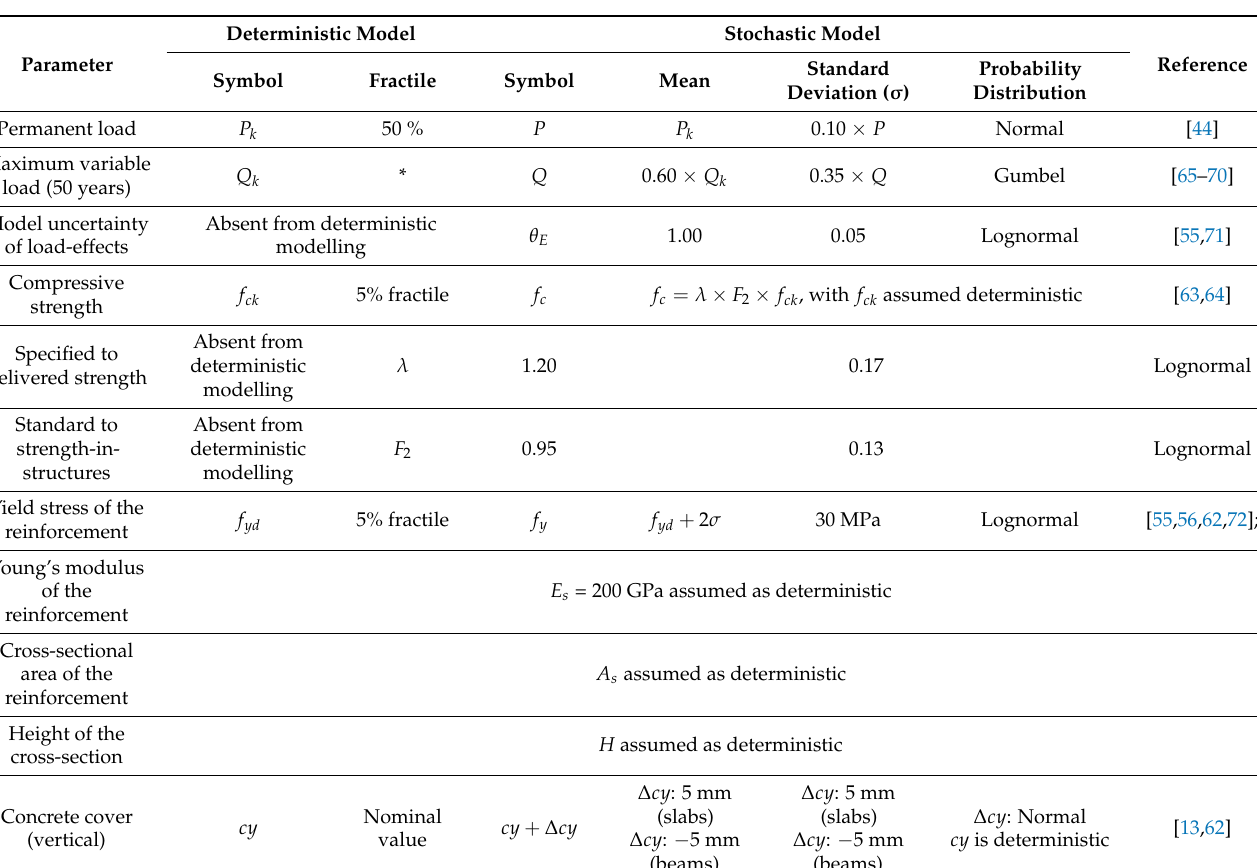
Table 5. Deterministic and stochastic modelling of load-effects, geometry, and material properties.